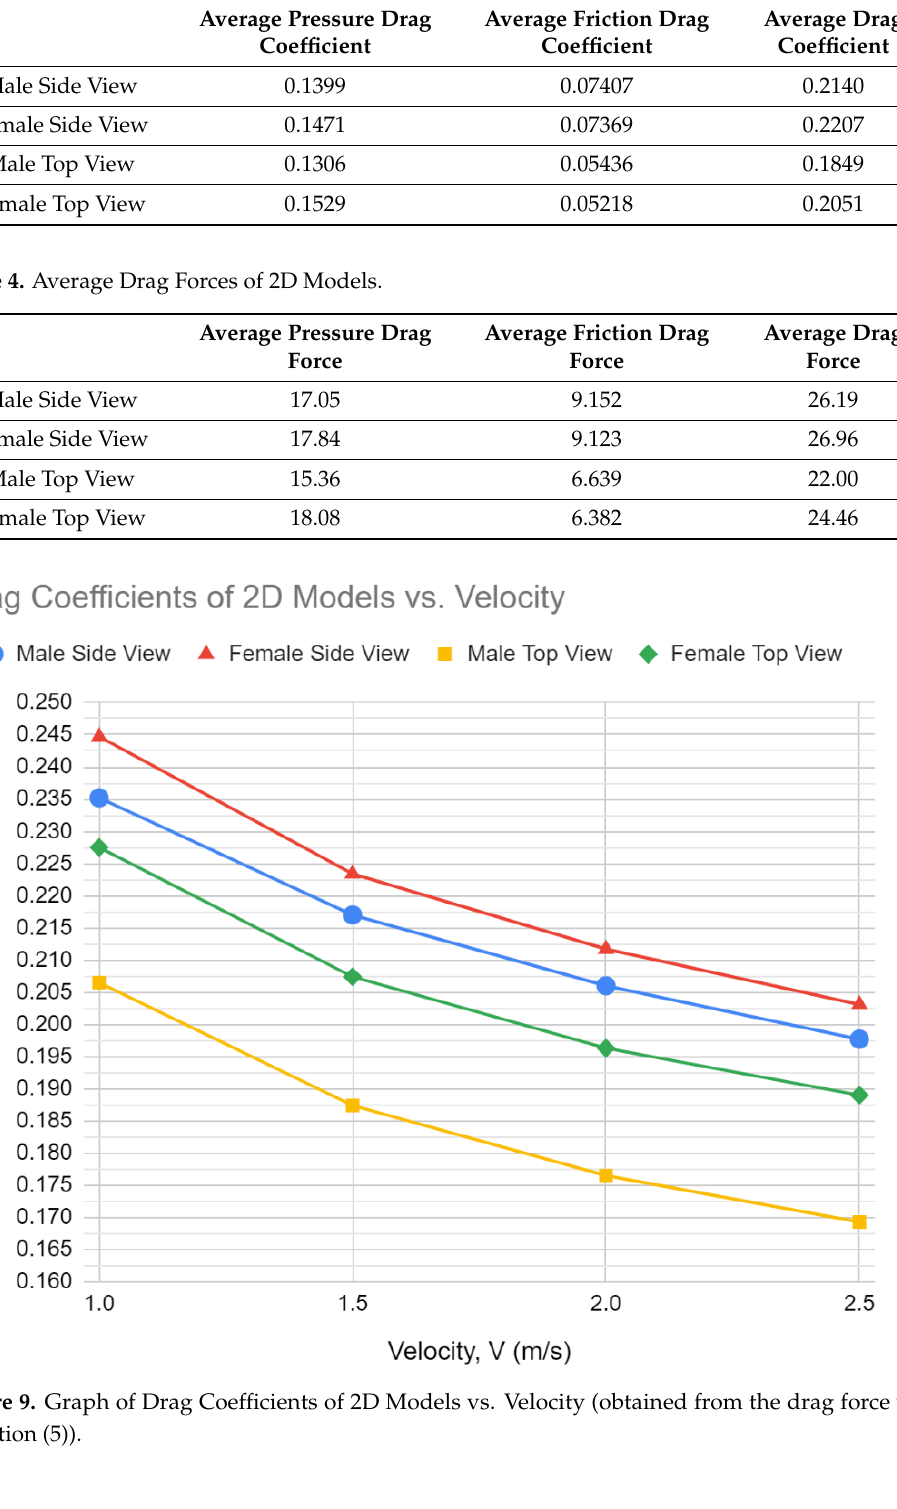
Figure 10. Graph of Drag Forces of 2D Models vs. Velocity.